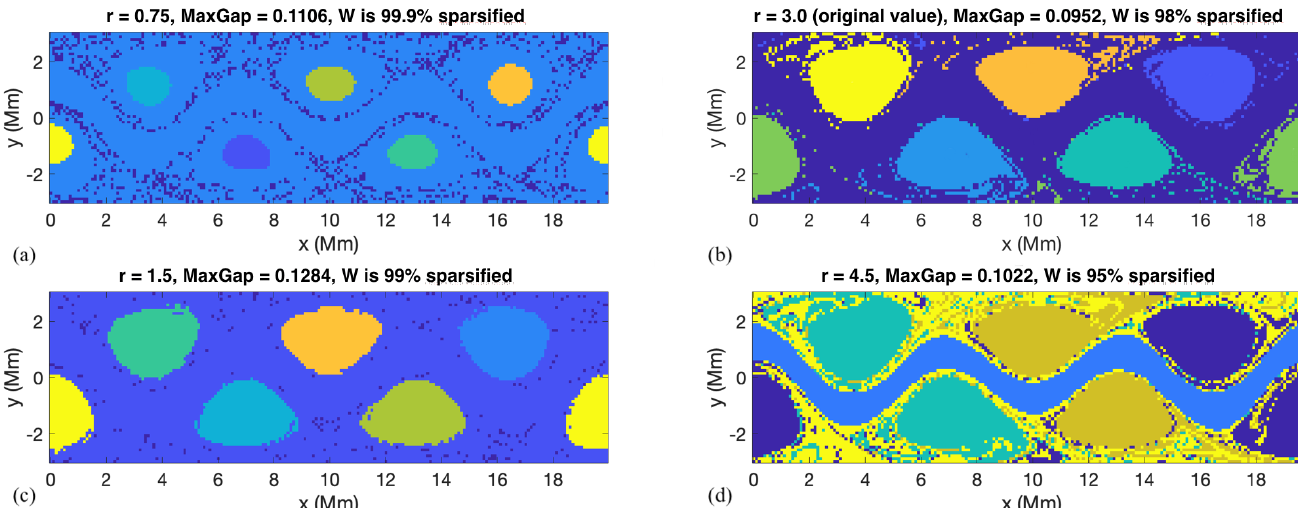
Figure 1. Example spectral clustering results for the Bickley Jet with parameters identical to those from HA16. The originally chosen value was r = 3.0 in panel ( b ). Three other values of r yielded a higher eigengap, however, as seen in panels ( a , c , d ). Moreover, to follow the rule of thumb of 5–10% sparsification, r = 4.5 in panel ( d ) should be chosen instead. This value fails to detect the individual vortices, instead grouping them in pairs. It does, however, detect the meandering jet as an individual coherent structure. Looking at the maximum eigengap, the value of r = 1.5 in panel ( c ) should be